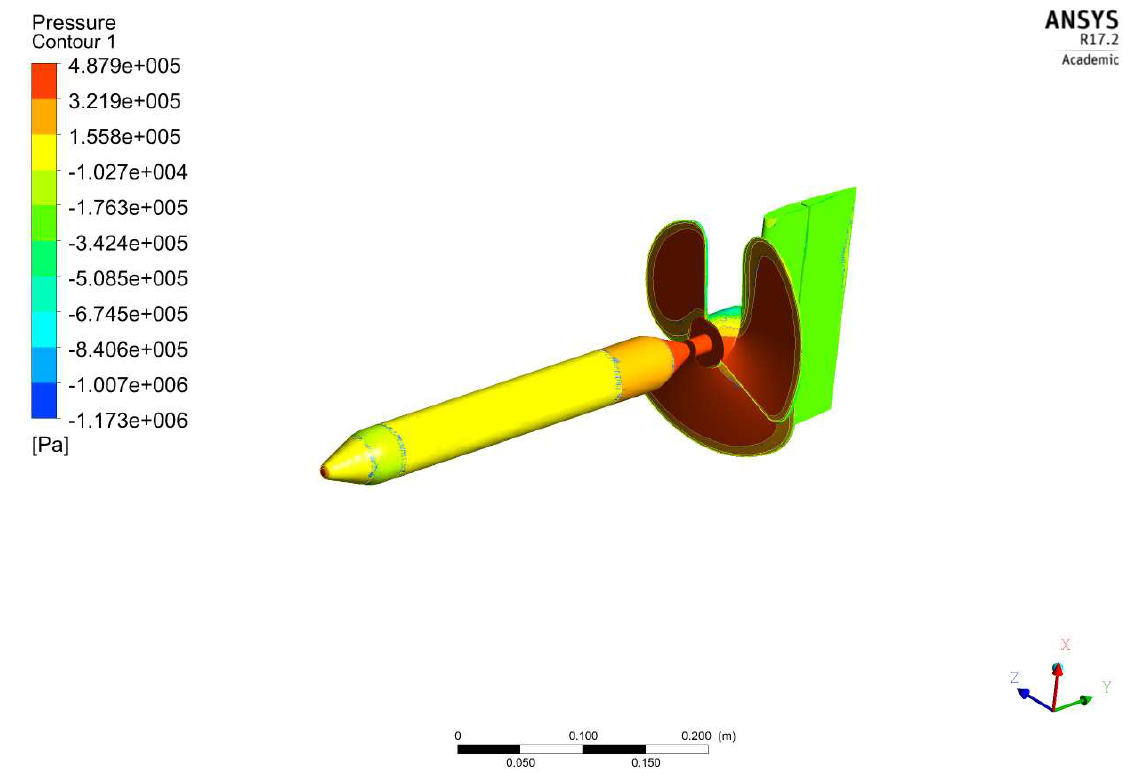
Aerospace 2022 , 9 , x FOR PEER REVIEW Figure 28. Hydrodynamic pressure distributions on aquatic vehicle model 1. Figure 28. Hydrodynamic pressure distributions on aquatic vehicle model 1.